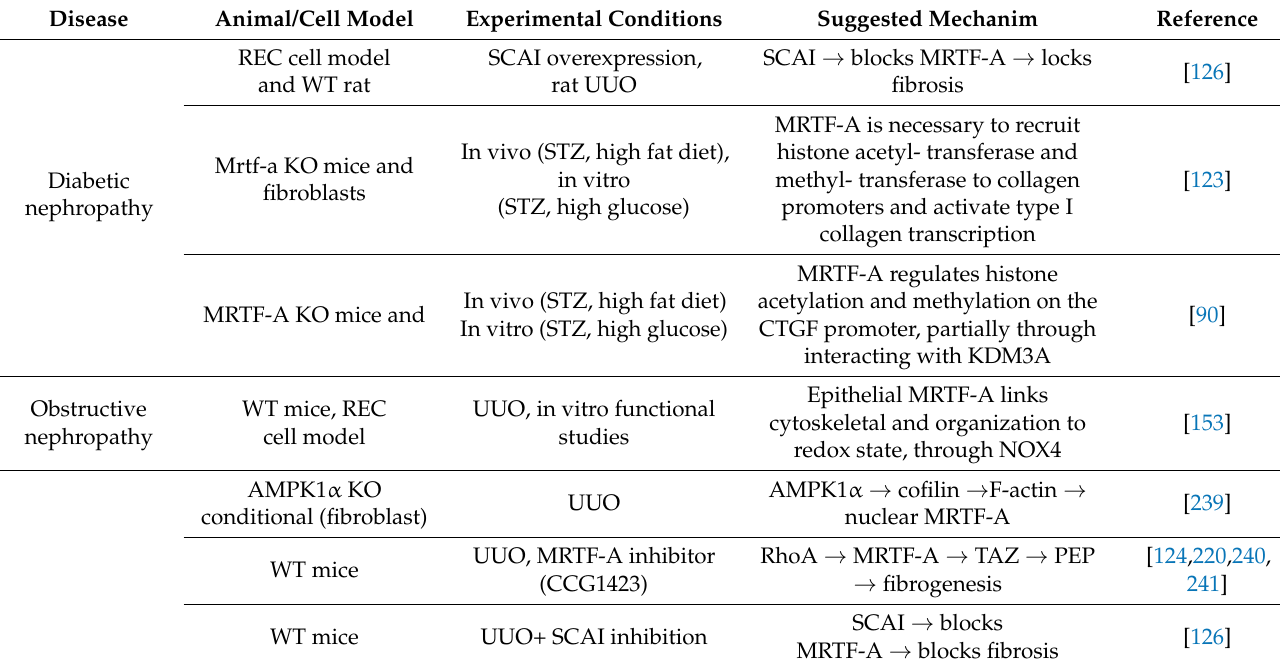
Table 4. MRTF in kidney